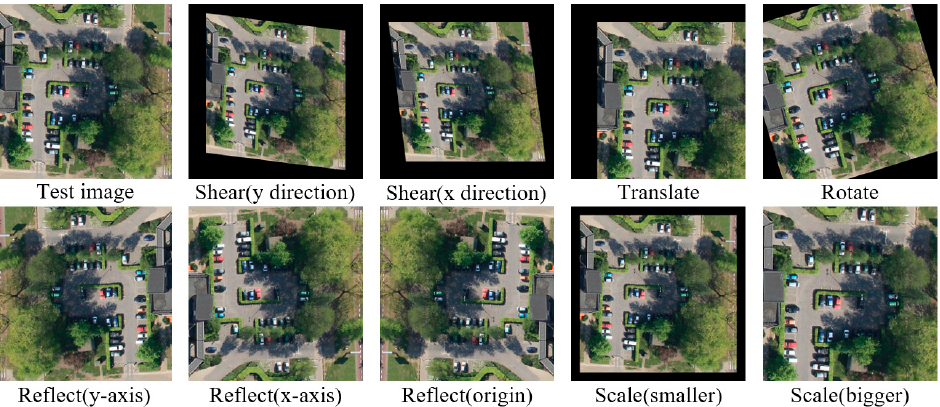
Figure 2. Illustrations of different affine transformations matrix.